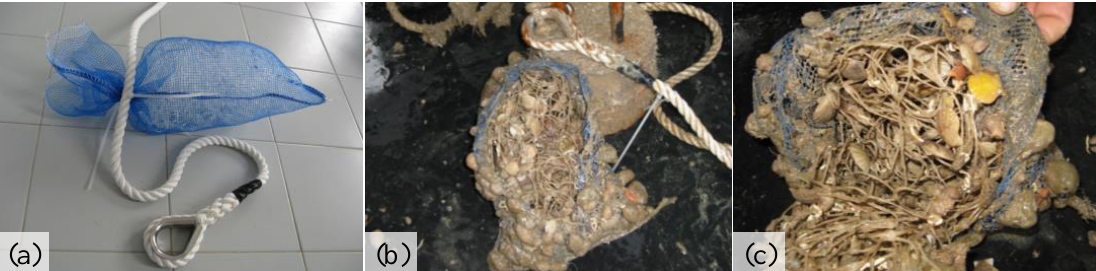
Figure 2. Net bag collectors before ( a ) and after ( b , c ) deployment in Pellestrina (PII) commercial mussel park.